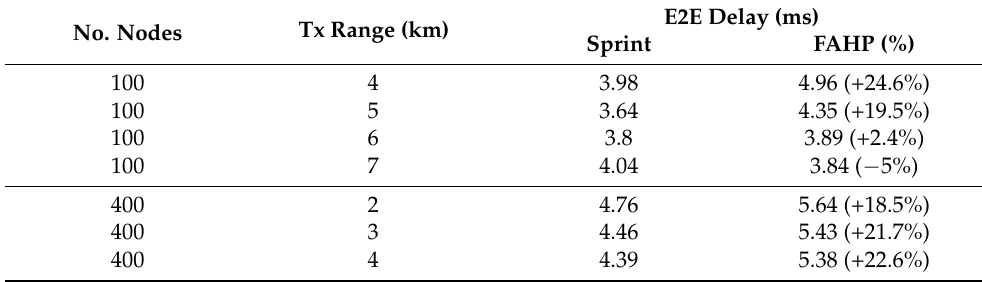
Table 13. Statistical comparison for average energy consumption.